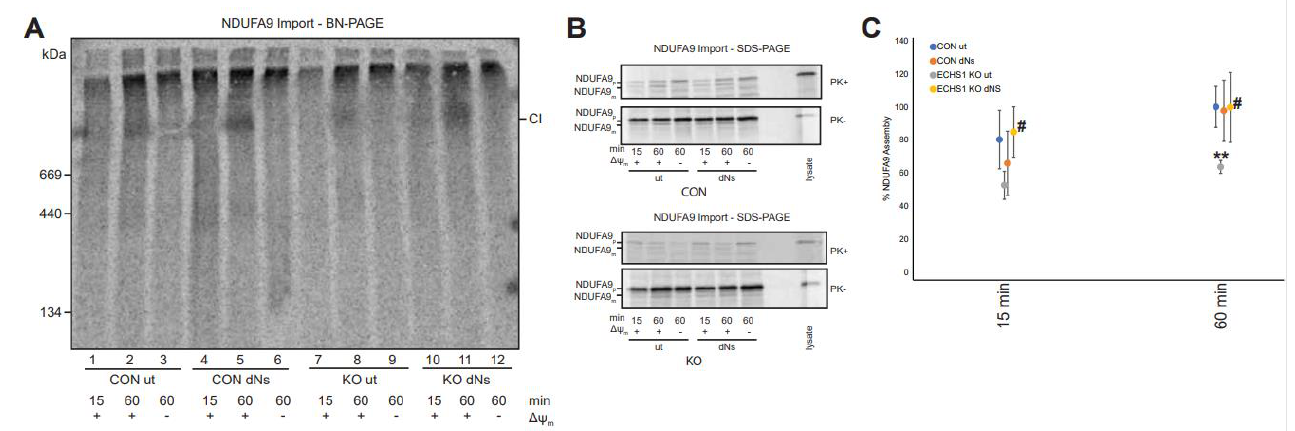
Figure 5. dNs treatment increases NDUFA9 assembly into complex I in ECHS1 KO cells. ( A ) BN- PAGE showing the assembly of NDUFA9 into mature complex I (CI) following solubilisation of 40 μ g mitochondria per lane in 1% TX-100. ( B ) SDS-PAGE showing NDUFA9 following import into both untreated and dNs treated CON and ECHS1 KO mitochondria. NDUFA9 is detectable in its precursor (p) form and as a proteinase K (PK+) resistant mature (m) form. ( C ) Quantitation of